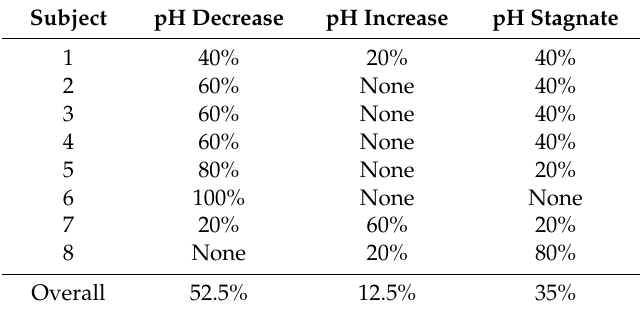
Table 1. All hair pH measurement results itemized to pH decreasing from hair sheath to external hair shaft (pH difference ≥ -0.5), increasing from hair sheath to external hair shaft (pH difference ≥ +0.1), and pH stagnation (remaining hairs).